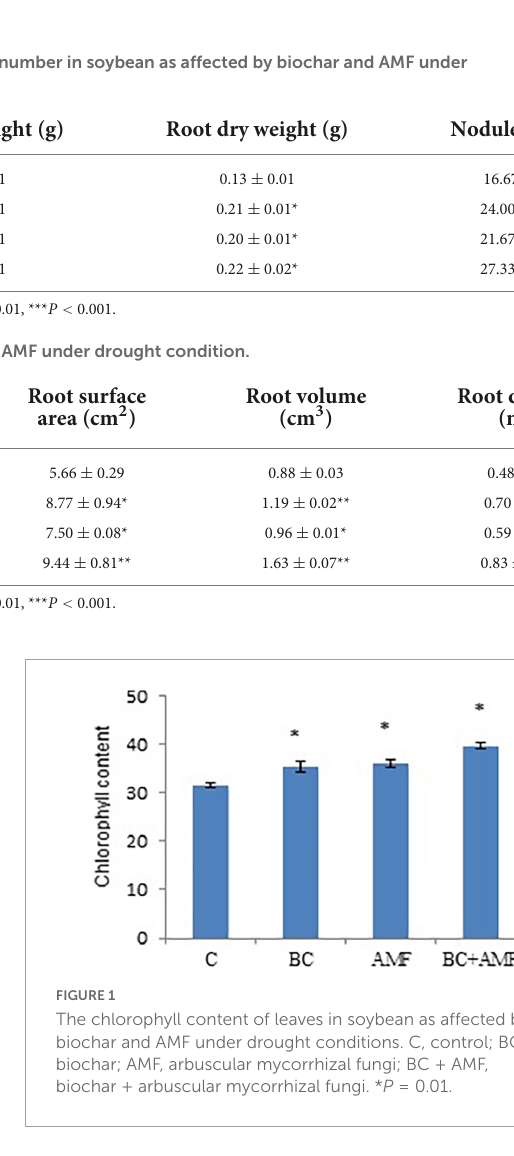
In drought stress, AMF and biochar alone significantly improved the microbial biomass, it increased 14.1 and 20.7%, respectively under drought conditions over the control ( Figure 3 ). In drought stress, dual with biochar and AMF increase microbial biomass by 28.3% in soil compared with the control. The combined application of AMF and biochar under drought stress led to the maximum microbial biomass compared to all